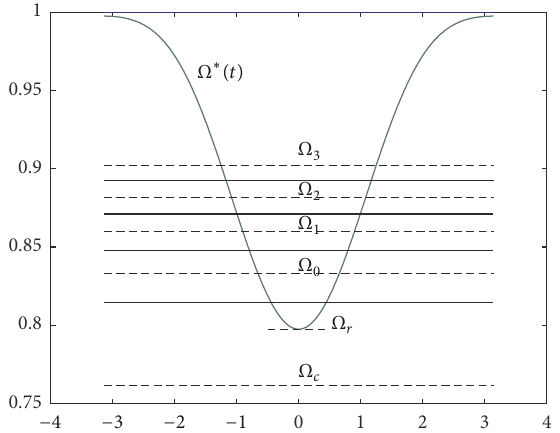
Figure 4: The energies for which constructive (solid horizontal lines) and destructive interference (dashed horizontal lines) occur. The curve stands for Ω ∗ (𝑡) , its minimum value is Ω 𝑟 , and Ω 0 − Ω 𝑟 = Ω − Ω 𝑟 𝑐 .